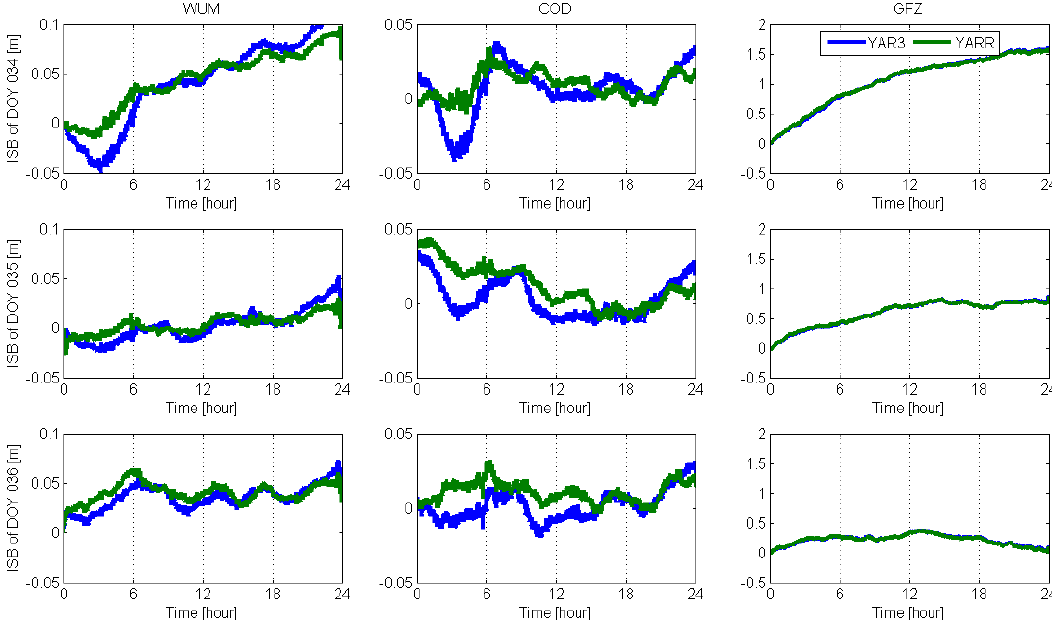
Figure 5. GPS / BDS ISB series of YARR and YAR3 stations estimated using WHU, CODE and GFZ Figure 5. GPS/BDS ISB series of YARR and YAR3 stations estimated using WHU, CODE and GFZ precise products on DOY 034–036, 2018. precise products on DOY 034 – 036, 2018.